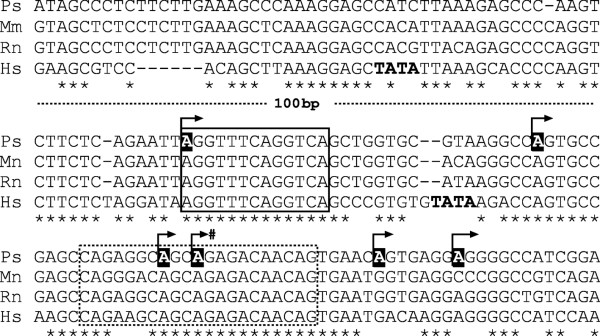
Alignment of the human and three rodent proximal Ucp3 promoter regions. Positions of identical bases are marked (*). The PPRE/TRE (box) as well as the MyoD binding triple E-box (dashed box) are highly conserved. Two TATA-like boxes (bold) can only be found in the human promoter. Transcriptional start sites of P. sungorus were identified within a wide range (black background), the arbitrarily chosen reference TSS is indicated (#). Rn = R. norvegicus, Mm = M. musculus, Ps = P. sungorus, Hs = H. sapiens